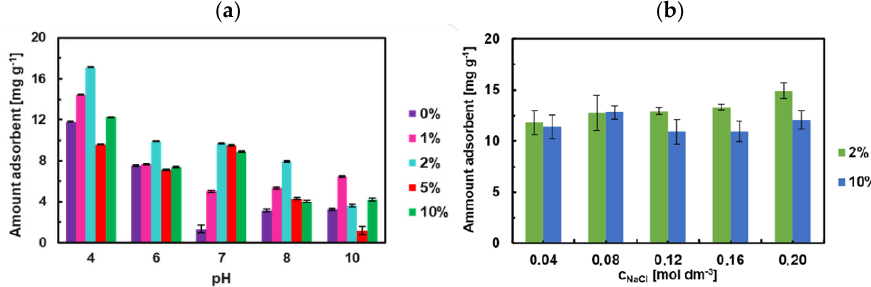
Figure 18. The ( a ) effect of pH and ( b ) the ionic strength on the adsorption of Congo red at pH